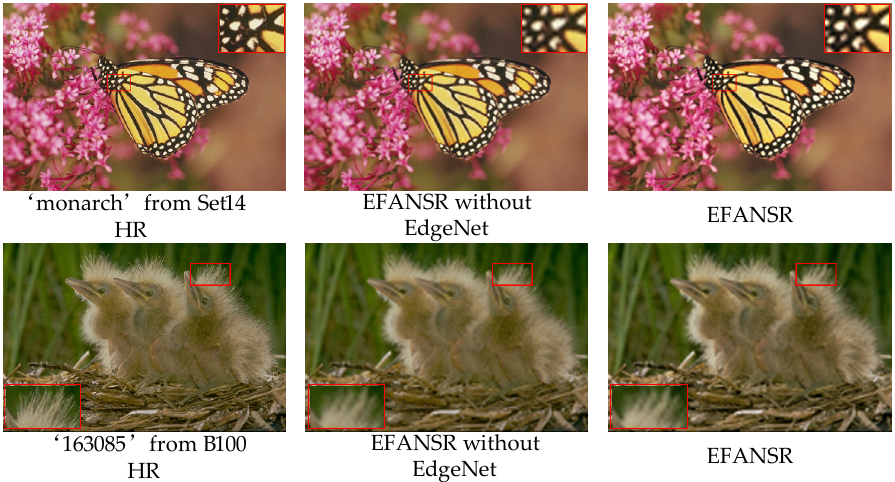
Figure 8. Visual comparison for EdgeNet. We compared the results of models with and without EdgeNet on 3× SR.